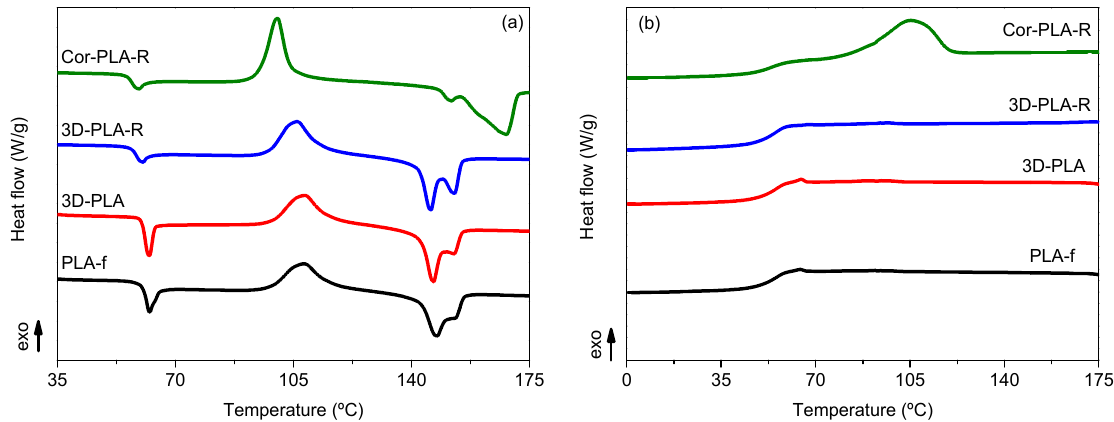
Figure 6. Differential scanning calorimetry (DSC) first heating ( a ) and cooling ( b ) scans of the samples before and after mechanical recycling.